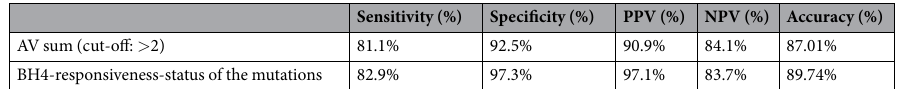
Sensitivity (%) Specificity (%) PPV (%) NPV (%) Accuracy (%)